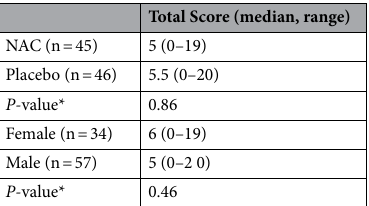
Total Score (median,